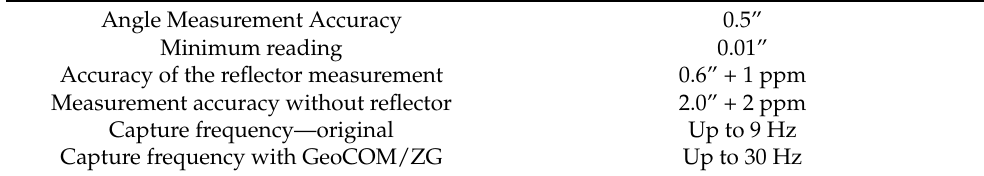
Table 3. Characteristics of the Polytec PDV 100 measuring